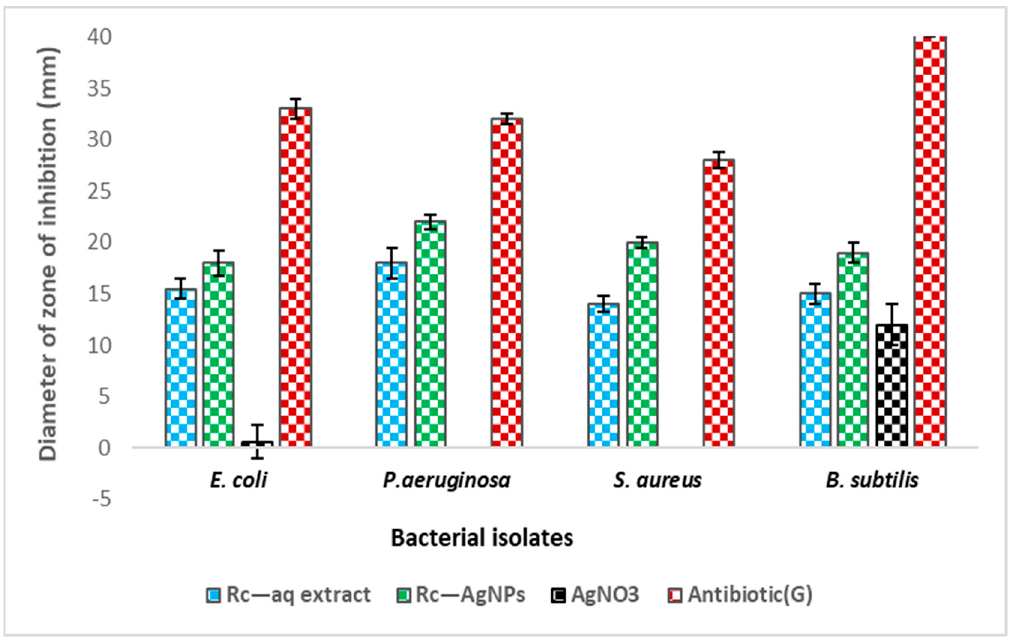
Figure 11. Effect of various treatments (red currant aqueous extract; red currant-AgNPs; AgNO 3 ) and antibiotic (Gentamycin-30 µ g) on the growth of Gram-positive and negative bacterial test isolates. Agar well-diffusion assay was conducted, and zone of inhibition (clear zones-mm) around each well was measured. The values in the experiment are means of three replicates run for each set (SD ± ). Significant differences in means ( p ≤ 0.05) were determined by analysis of variance ANOVA and Turkey HSD. E. coli—Escherichia coli; P. aeruginosa—Pseudomonas aeruginosa; S.aureus—Staphylococcus aureus; B.subtilis—Bacillus subtilis